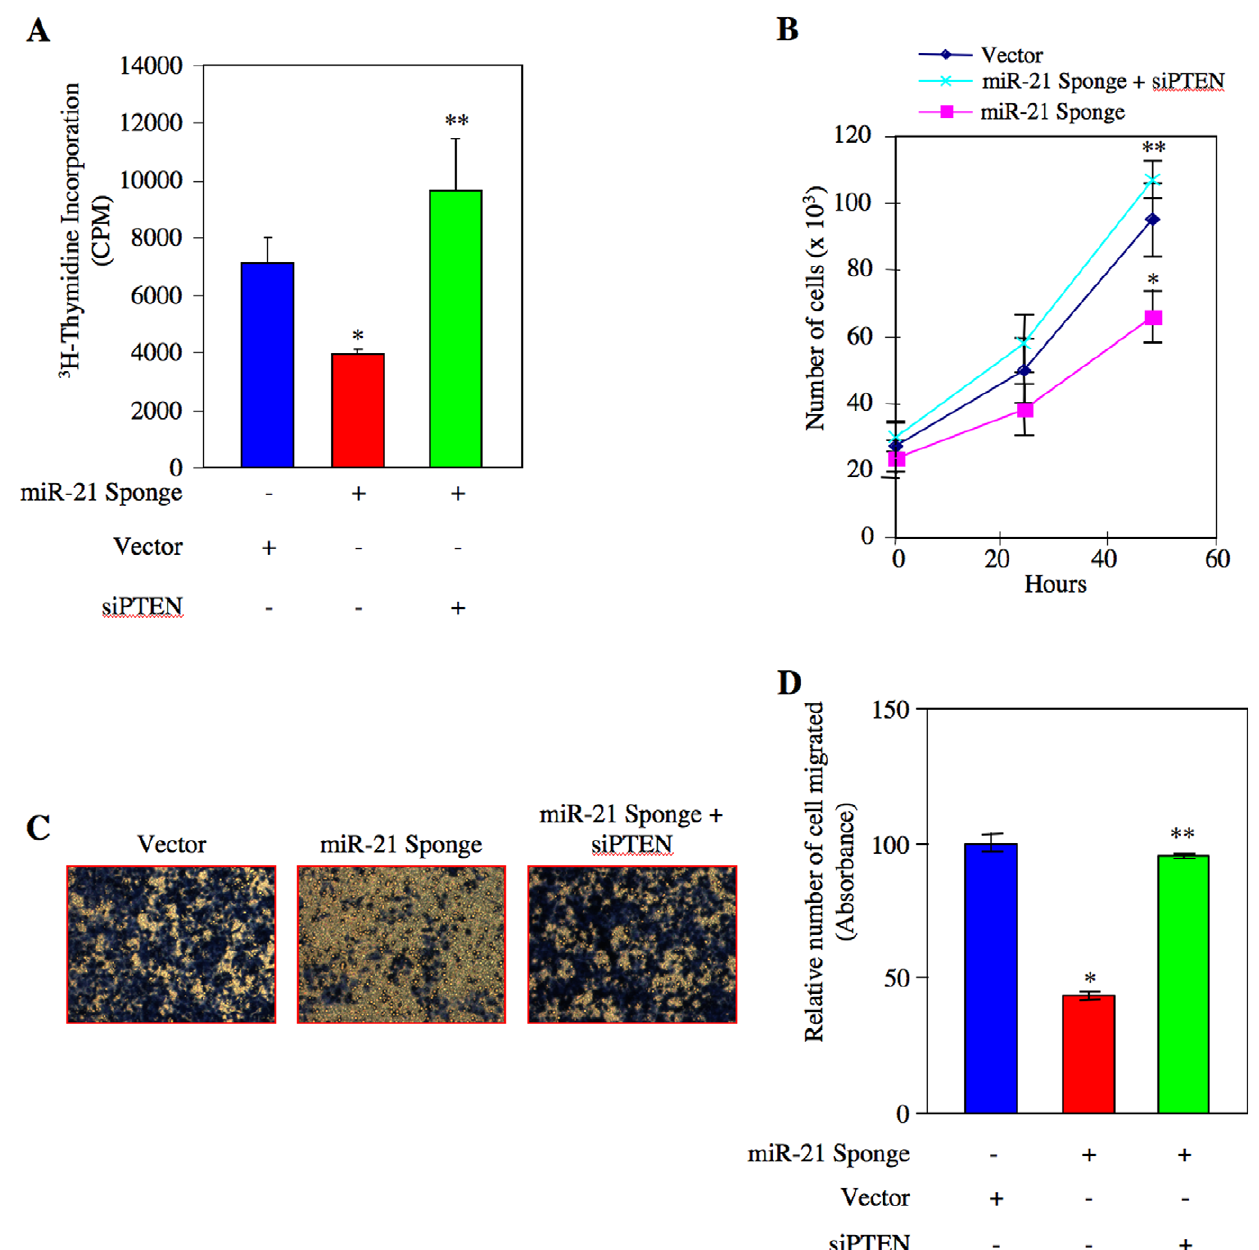
Figure 5. miR-21 targets PTEN to induce proliferation and migration of renal cancer cells. ACHN cells were transfected with miR-21 Sponge along with siRNA pools targeting PTEN mRNA as indicated. (A) 3 H-thymidine incorporation was determined as described in the Materials and Methods [115]. Mean 6 SE of 6 measurements is shown. *p , 0.05 vs vector; **p , 0.05 vs miR-21 Sponge-transfected cells. (B) Transfected cells were counted at indicated time periods. The symbols diamond, square and cross represent vector, miR-21 Sponge and miR-21 Sponge plus siRNA pool against PTEN, respectively. Mean 6 SE of triplicate measurements is shown. *p , 0.05 vs vector alone; **p , 0.01 vs miR-21 Sponge alone. (C) Transfected cells were seeded onto membrane in trans-well chambers and the migrated cells were stained as described in the Materials and